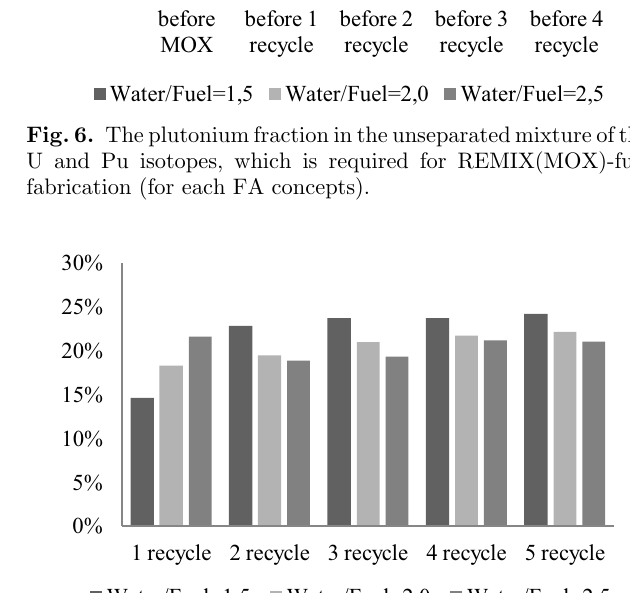
Fig. 7. Natural uranium consumption reduction for each FA concepts during multiple